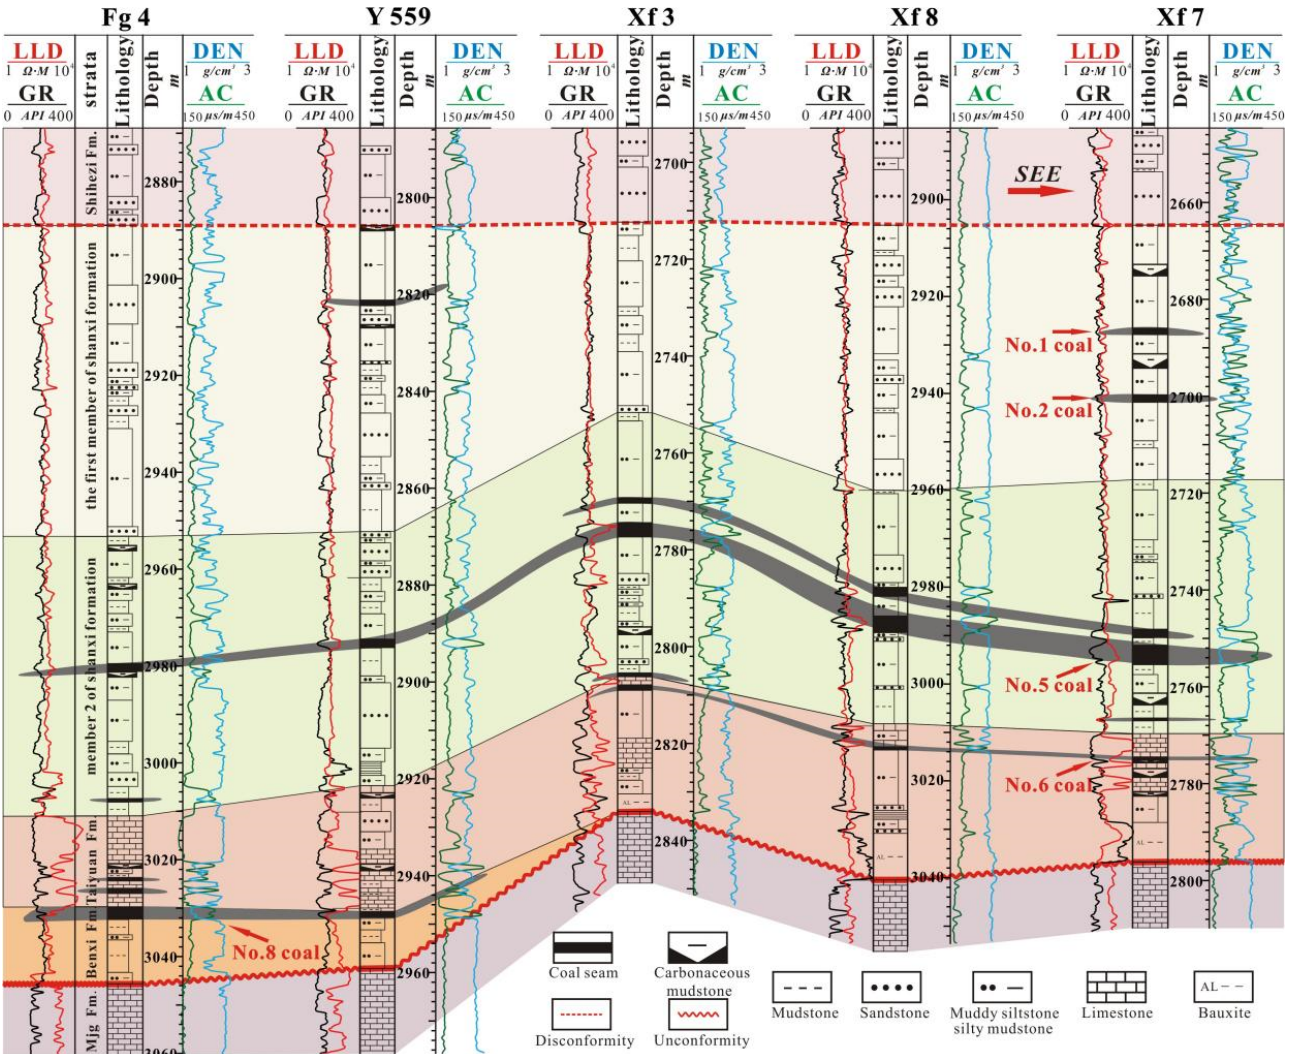
Figure 2. Profile of wells in the northern part of the study area.